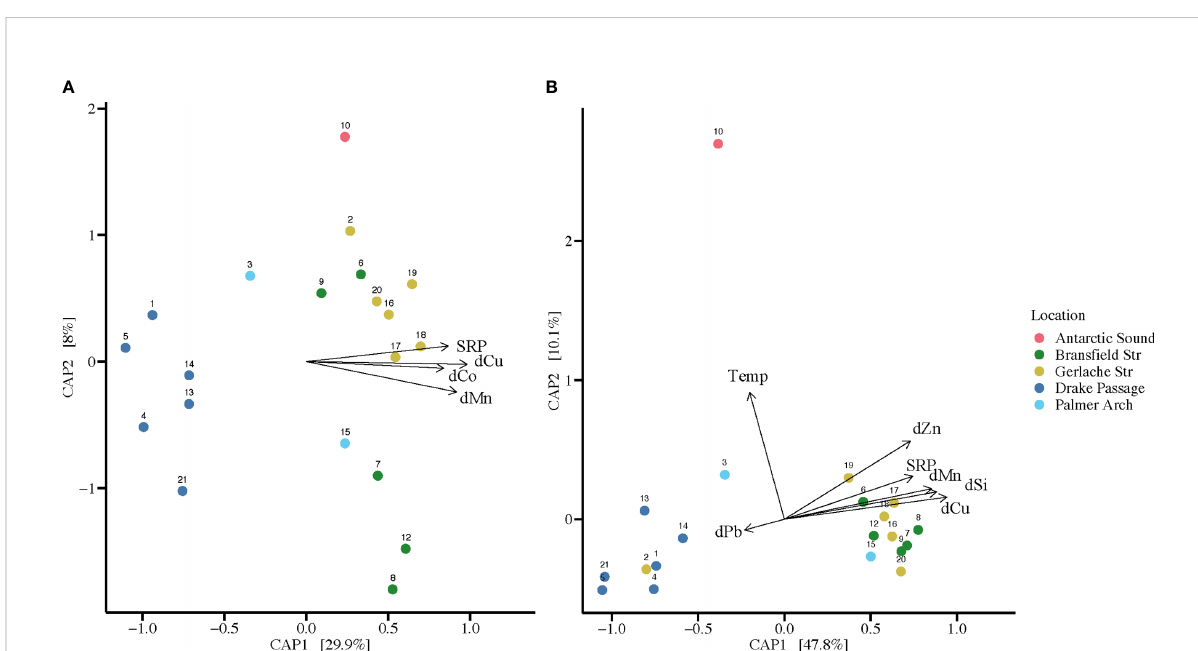
FIGURE 2 Canonical analysis of principal coordinates (CAP) using signi fi cant environmental parameters from the BIOENV test compared to taxonomic composition of communities per location from high-throughput sequencing. Environmental parameters from surface seawater shown include: soluble reactive phosphorus (SRP), dissolved silicic acid (dSi), dissolved manganese (dMn), dissolved cobalt (dCo), dissolved copper (dCu), dissolved zinc (dZn), dissolved lead (dPb), and water temperature (Temp). Colors of the points correspond to the sampling locations ( n = 20). Station 11 is not included since it did not have corresponding environmental parameters taken. (A) CAP plot of bacterial communities at each location sampled with vectors of environmental parameters. Dimensions 1 and 2 account for 37.9% of the variation. (B) CAP plot of diatom communities at each sampling location with vectors of environmental parameters. Dimensions 1 and 2 account for 57.9% of the